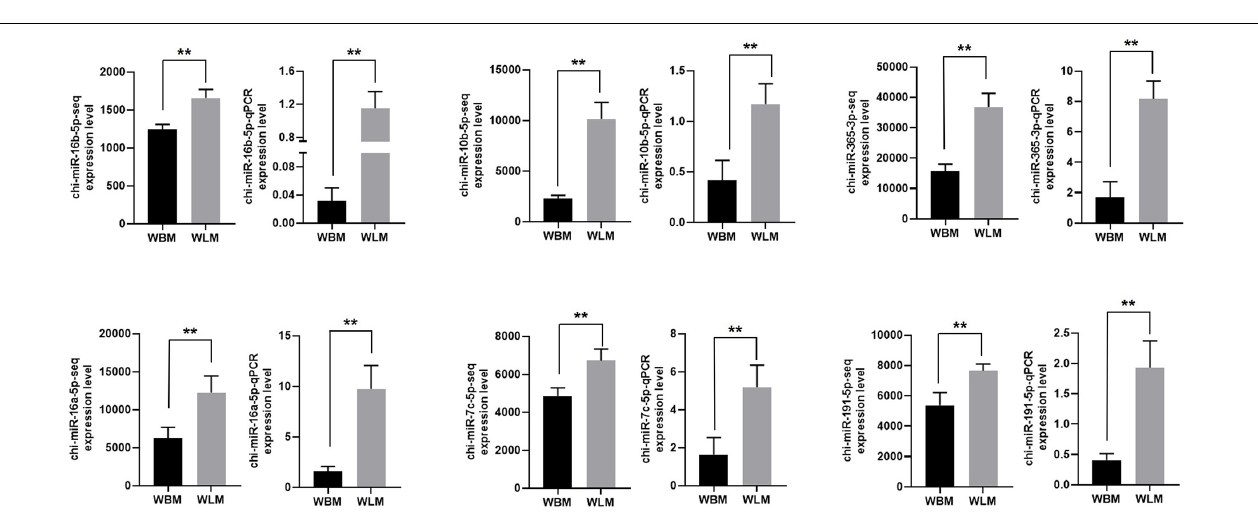
FIGURE 6 | Validation of the miRNA-Seq results. Biceps femoris muscle (WBM): high-fatty acid group. Longissimus dorsi muscle (WLM): low-fatty acid group. Expression of miRNAs were normalized by U6 snRNA. The asterisks represent the levels of significance ( t -test: ** P <